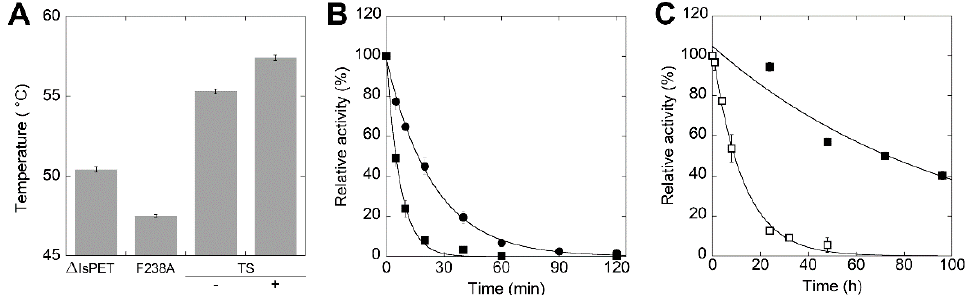
Figure 4. Thermal stability of Δ IsPET variants. ( A ) T m values of F238A and TS- Δ IsPET variants determined by CD spectrometry at 222 nm (mean ± standard deviation); for TS variant the value is given in the absence ( − ) and in presence (+) of 10% glycerol. Measures were performed in duplicate. ( B ) Time course of thermal inactivation of Δ IsPET ( ● ) and F238A- Δ IsPET variant ( ■ ) at 50 °C. ( C ) Time course of thermal inactivation of TS- Δ IsPET variant in the absence ( □ ) and in presence ( ■ ) of 10% glycerol. Reaction conditions in panels B and C: 50 mM sodium phosphate buffer, 100 mM NaCl, pH 8.0, at 50 °C with 0.15 mg mL − 1 Δ IsPET variants. Residual activity was detected by the p NPA assay. The activity value determined at time = 0 min was set as 100%; values are reported as mean ± standard deviation ( n = 3).